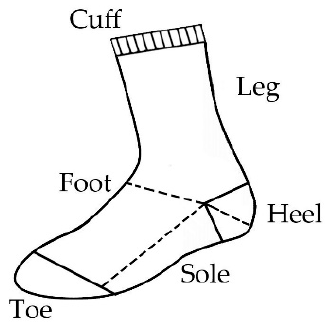
Figure 1. Different parts of socks.